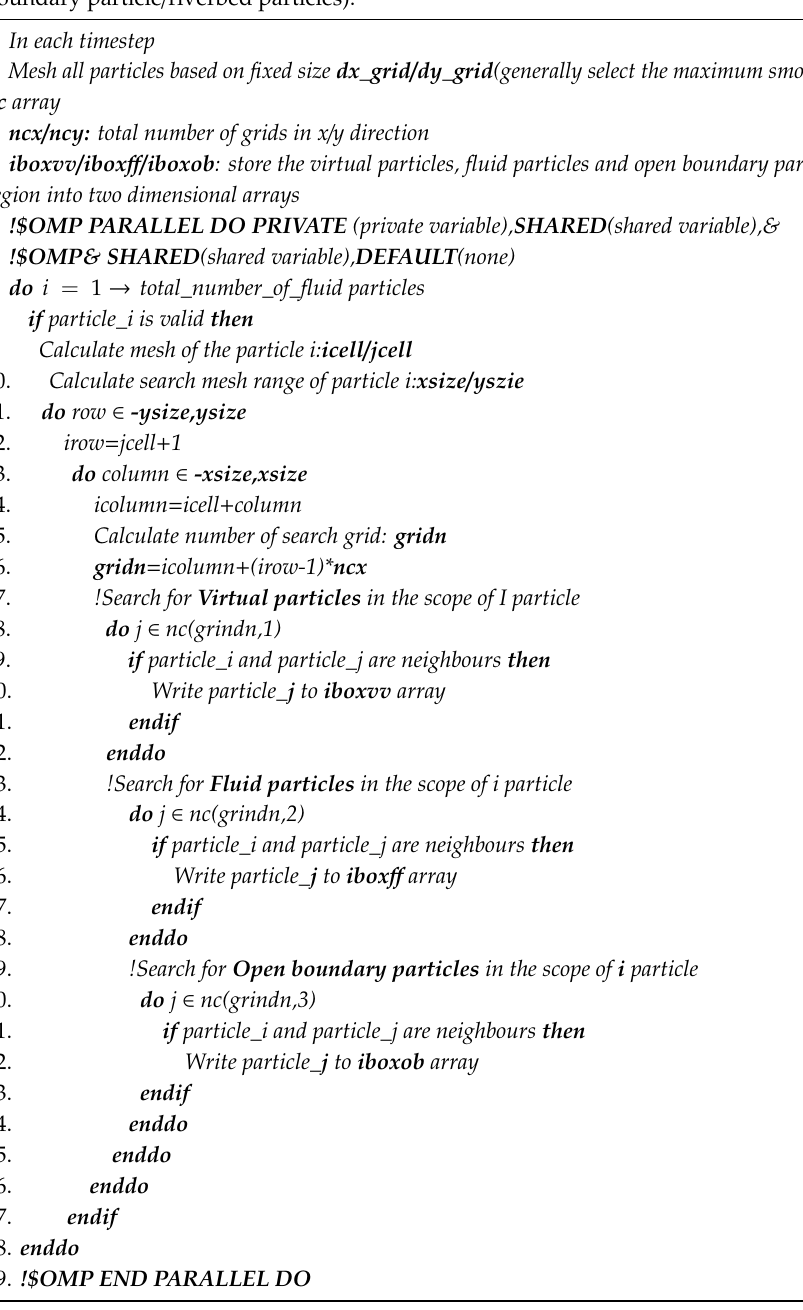
Algorithm 3: The particle search. Read in the particles data (include fluid particles / virtual parti‘cles / open boundary particle / riverbed